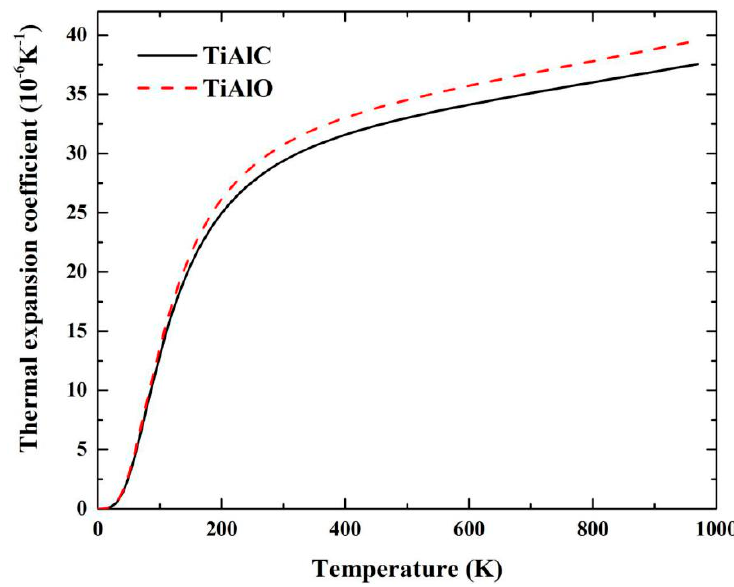
Figure 4. The volume thermal expansion coefficient as a function of temperature, where the solid line represents TiAlC and the dashed line represents TiAlO.